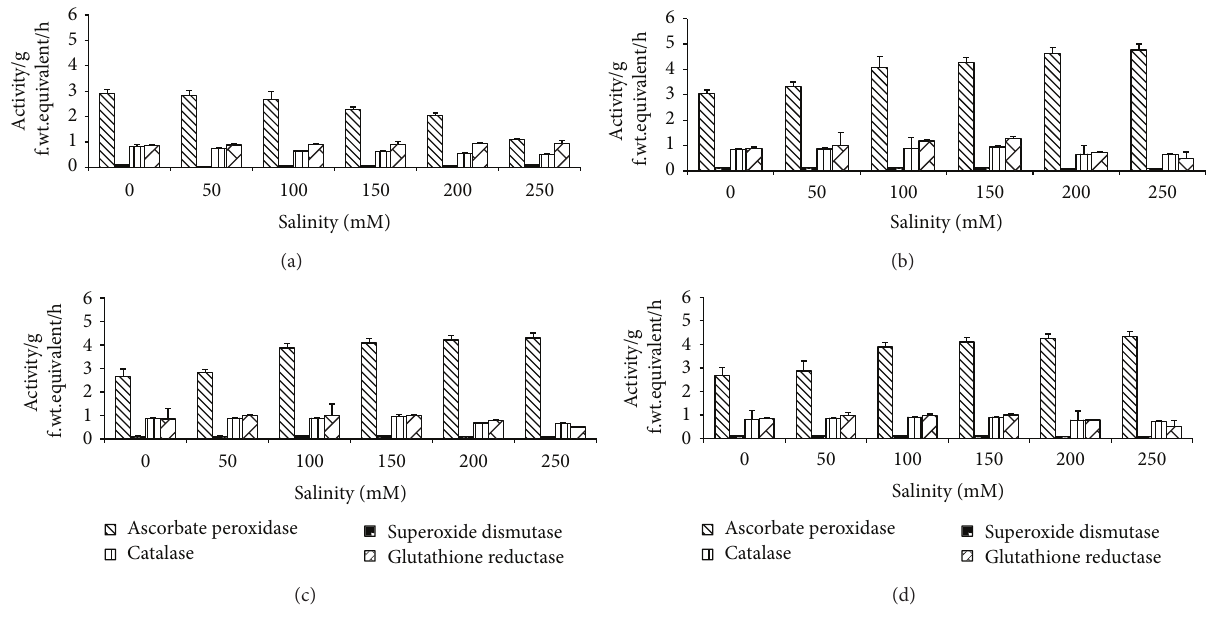
Figure 4: Effect of NaCl on enzyme activity of T. aestivum grains presoaked in different concentrations of Ulva lactuca : (a) control, (b) algal extract 1%, (c) algal extract 5%, and (d) algal extract 10%. Data are the mean of three replicates and error bars represent the standard errors of the